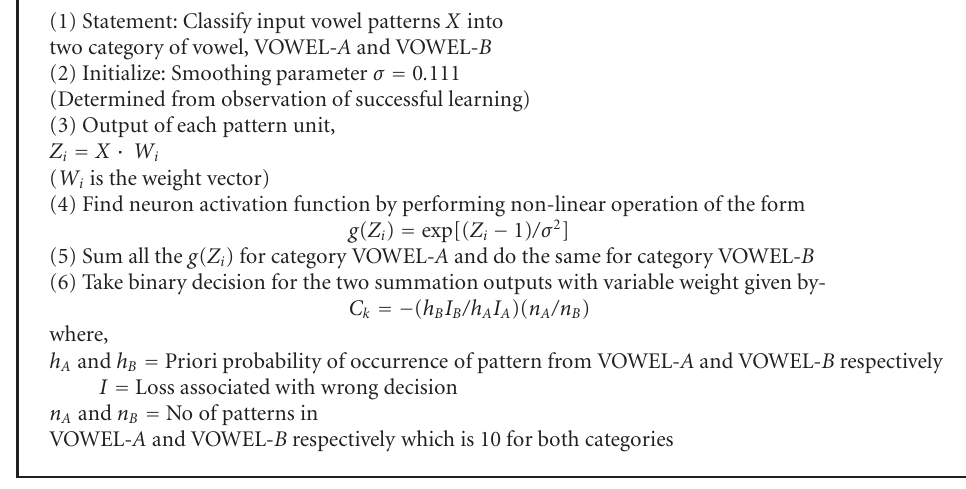
Algorithm 2: PNN learning